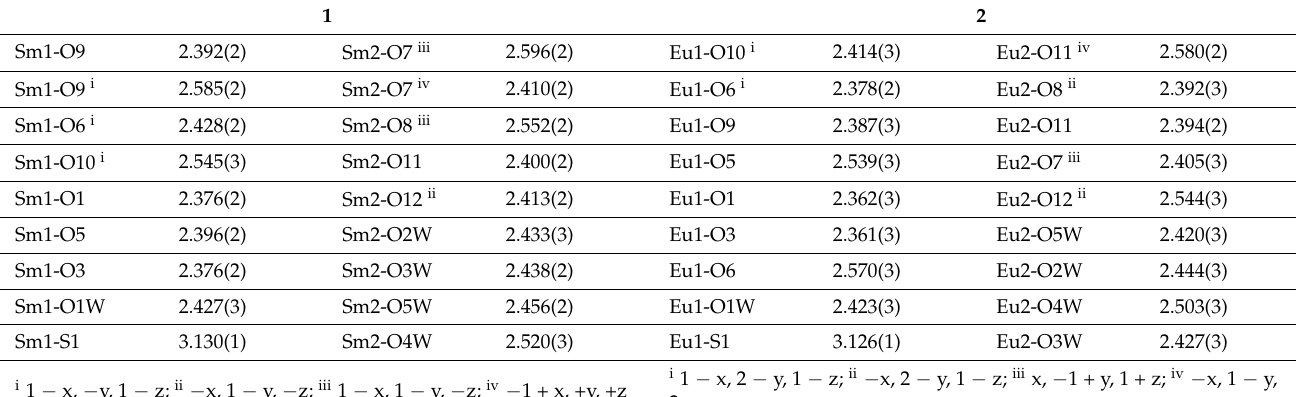
Table 3. Bond lengths (Å) around central atom for 1 and 2 .